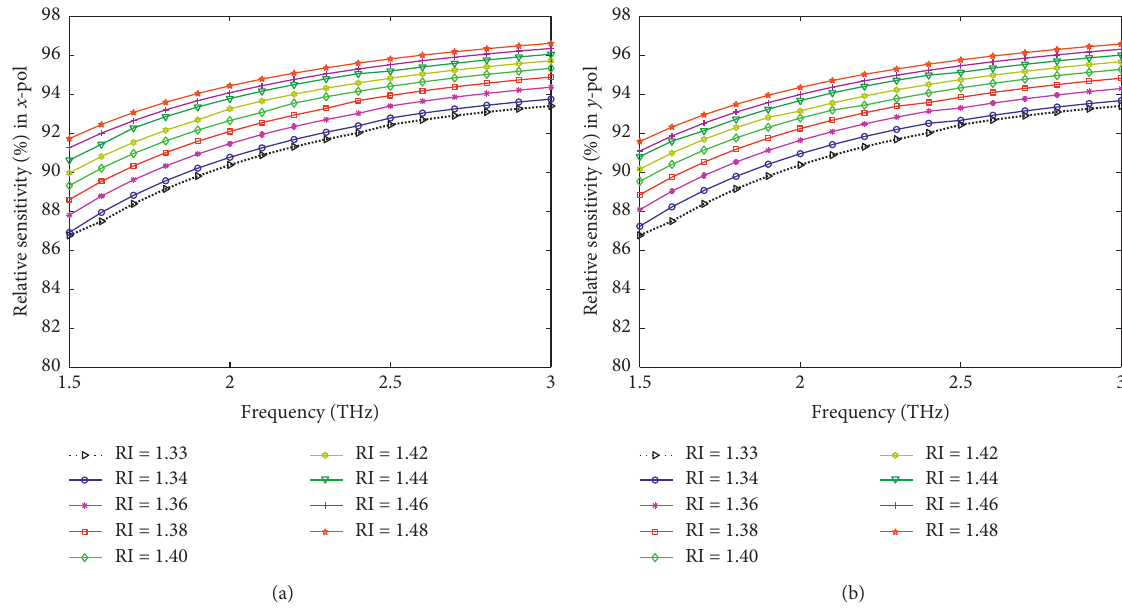
Figure 20: Depiction of the relative sensitivity profiles of the proposed model for different analytes. (a) x -PoM and (b) y -PoM. Table 4: Comparison of the sensing performance of the proposed model for different analytes at 2.5THz.